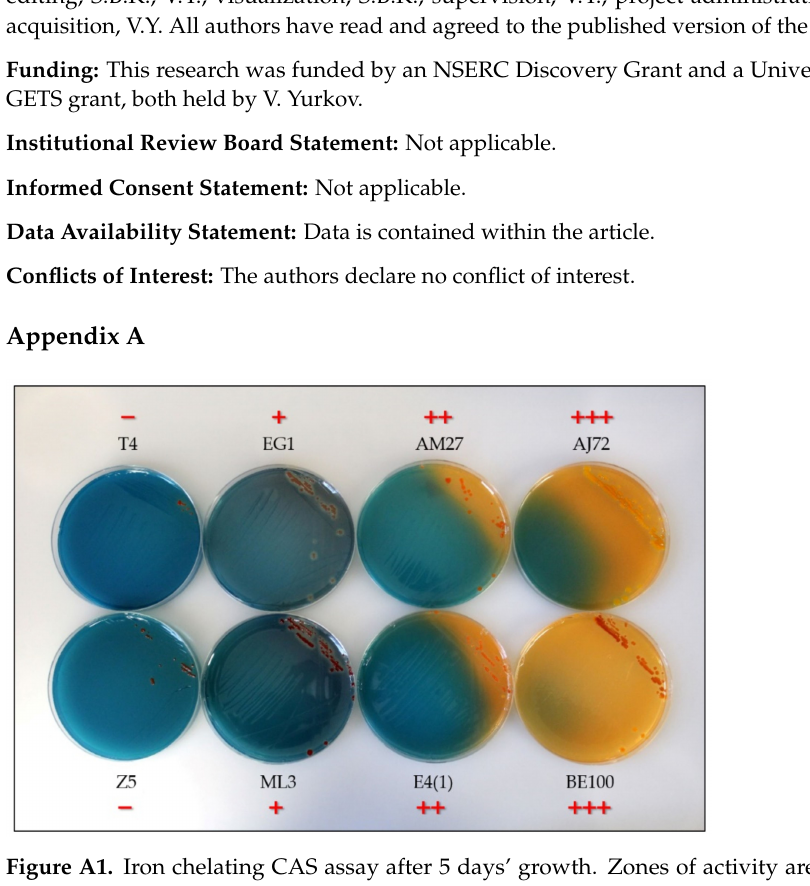
Figure A1. Iron chelating CAS assay after 5 days’ growth. Zones of activity are separated into 4 groups based on range of colour change, as indicated in red by each strain name.